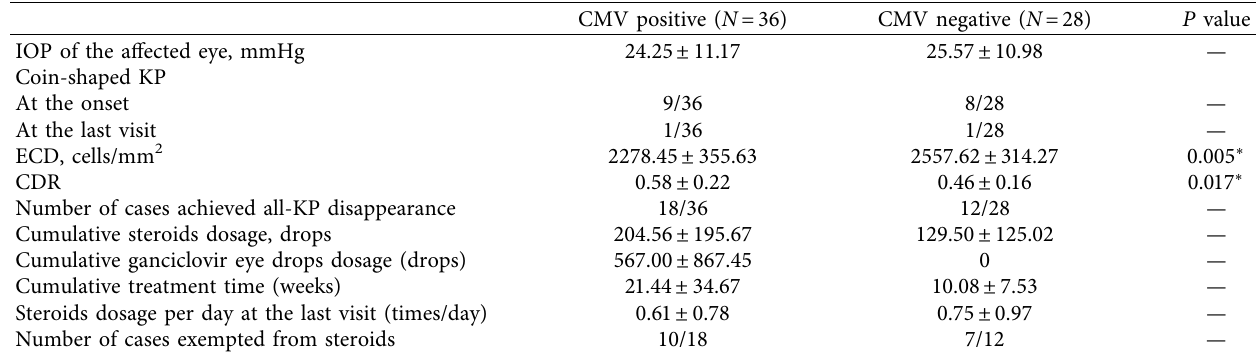
Table 2: Comparison of patients from the CMV-positive and CMV-negative